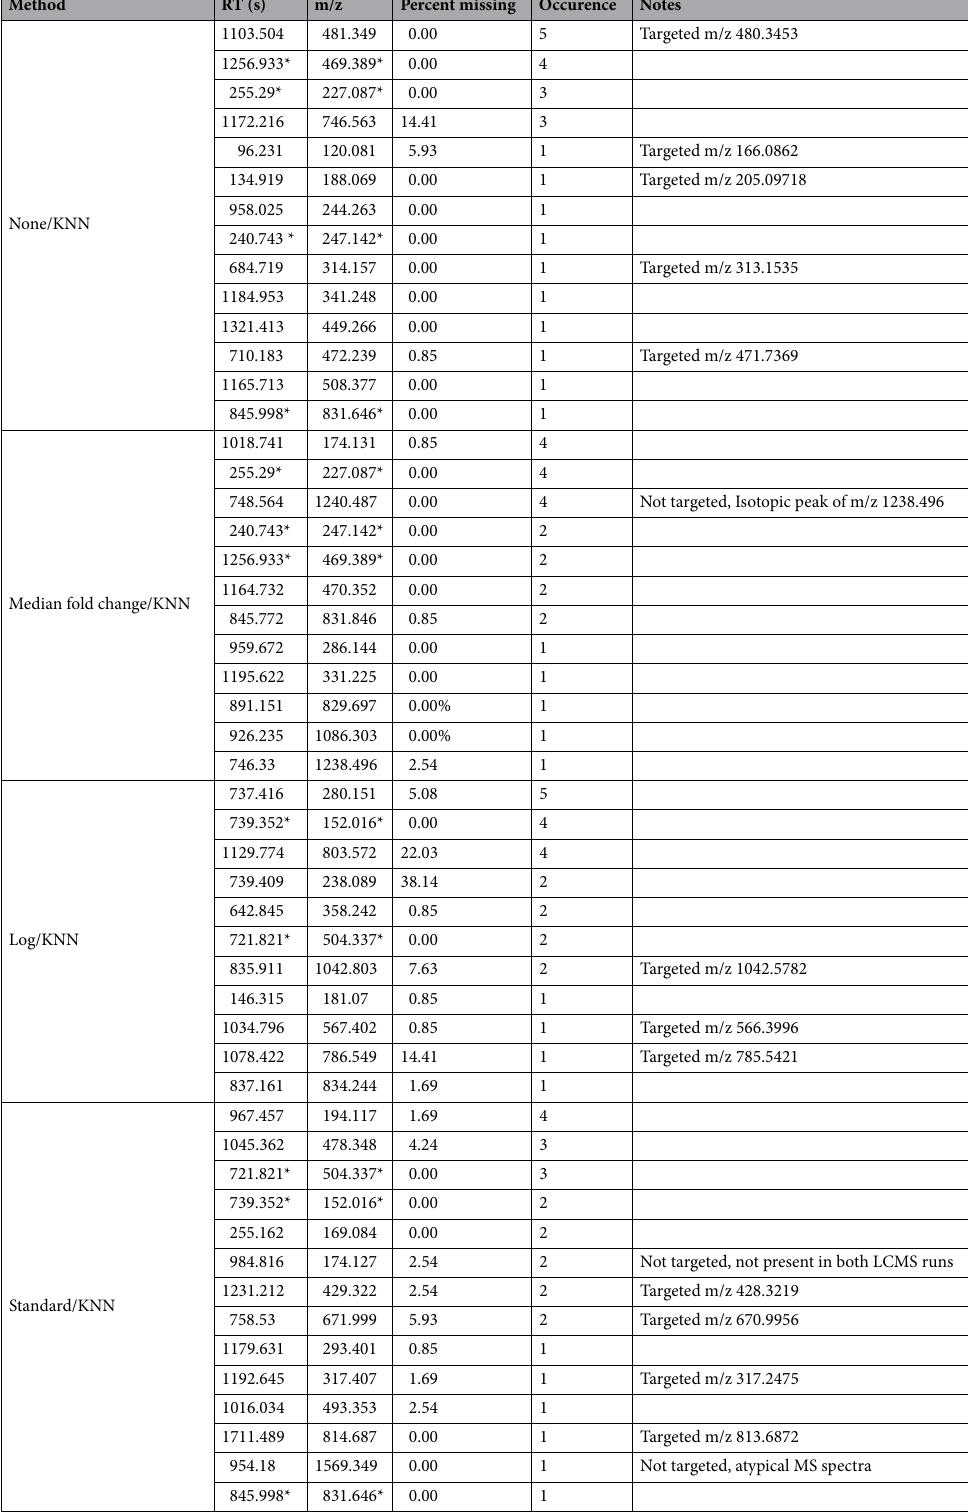
Table 2. Biomarkers selected by k FFS on training samples. The RT column indicates the retention time in seconds. The M/Z column indicates the mass divided by charge of the metabolite. The percent missing column indicates the percentage of samples that were missing the specific feature. The occurrence column indicates how many times the feature occurred across the fivefold in k FFS. The method indicates the normalization/ imputation method used. A (*) on a feature indicates that it was picked more than once across